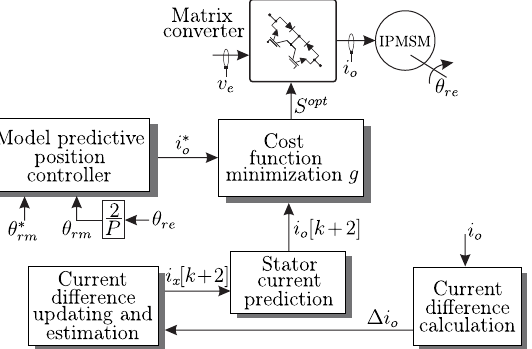
Figure 14. Predictive position and speed control block diagram.